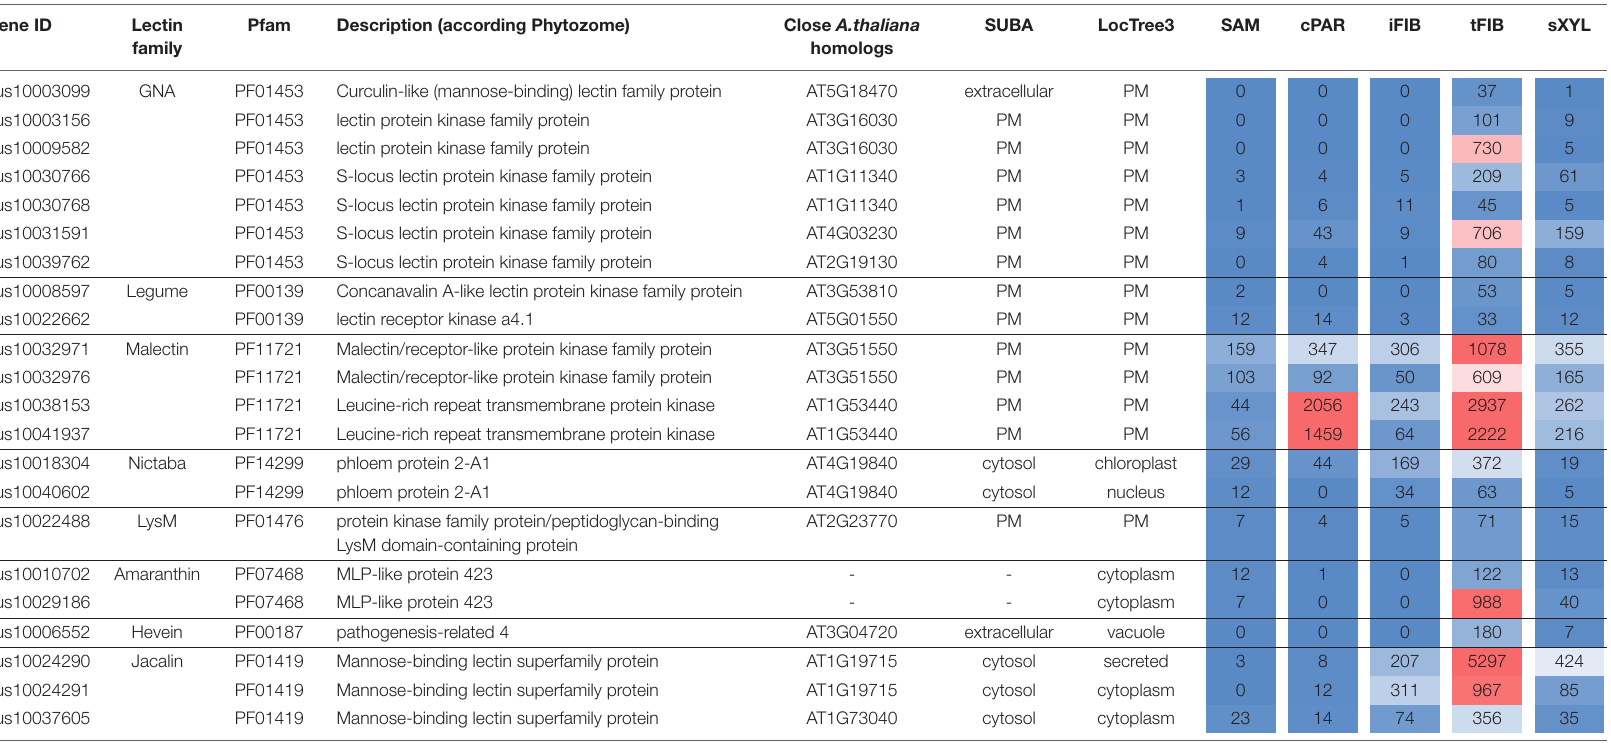
TABLE 5 | Linum usitatissimum genes encoding proteins with lectin domains upregulated in flax stem tissue samples with the tertiary cell wall. Gene